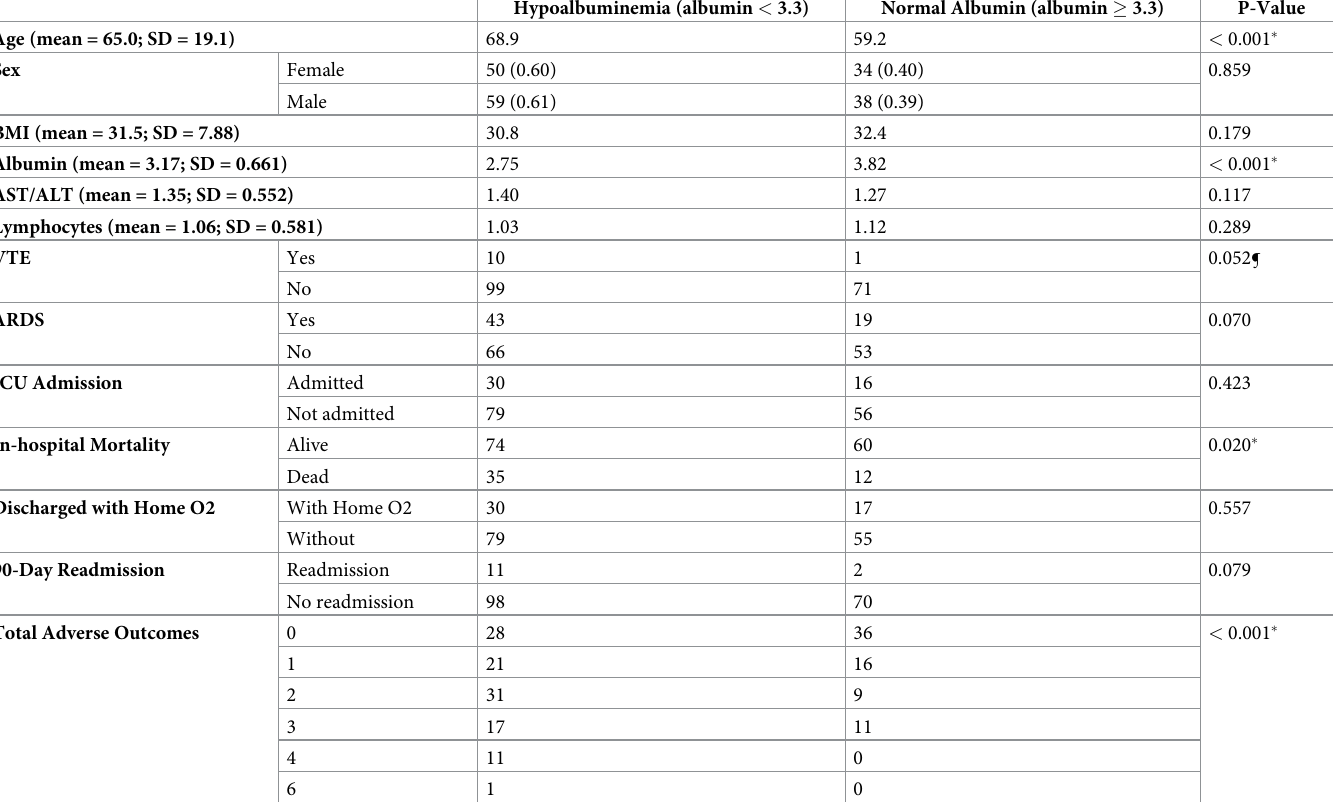
Table 1. Characteristics of the patient cohort with and without hypoalbuminemia.